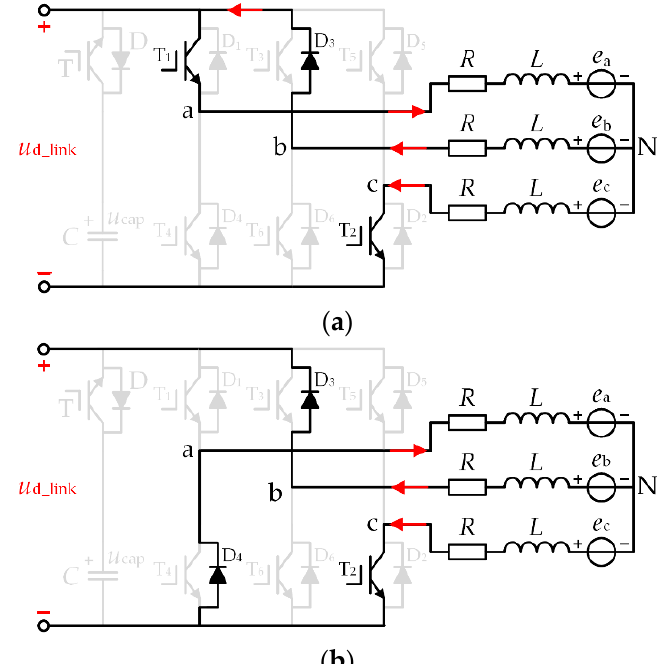
Figure 7. Equivalent circuit during the “a + b − → a + c − ” commutation period ( a ) switch T 1 ON ( b ) switch T 1 OFF. ( b ) switch T 1